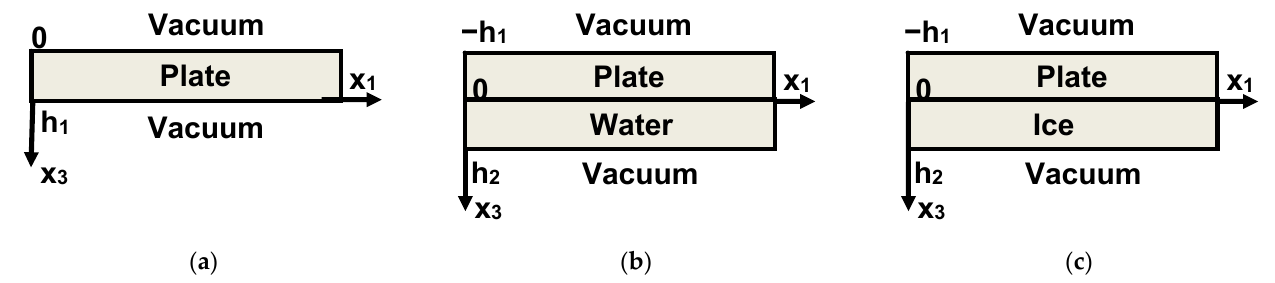
Figure 3. Geometries of the structures ( a ) “vacuum-Y,Z LiNbO 3 plate-vacuum”, ( b ) “vacuum-Y,Z LiNbO 3 plate—water layer—vacuum”, ( c ) “vacuum-Y,Z LiNbO 3 plate—ice layer—vacuum” considered theoretically.